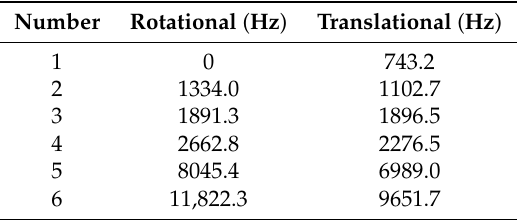
Table 2. Natural frequencies of the planetary